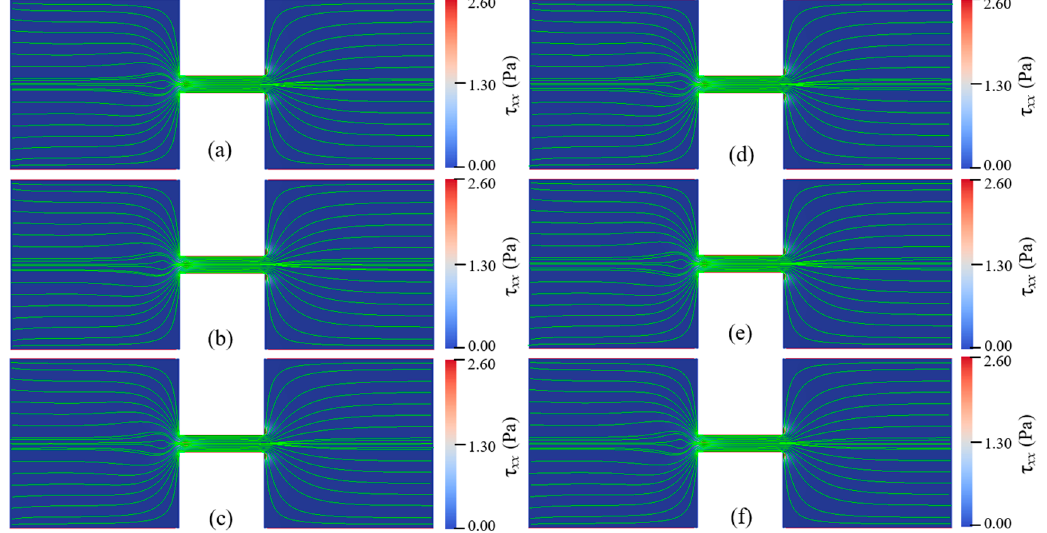
Figure A5. Streamlines of 150 ppm PAA solution under E app = 600 V/cm at different times: ( a ) 1.70 s, ( b ) 1.72 s, ( c ) 1.74 s, ( d ) 1.76 s, ( e ) 1.78 s, ( f ) 1.80 s. Zeta potential is − 70 mV. The color bar represents the elastic normal stress τ xx